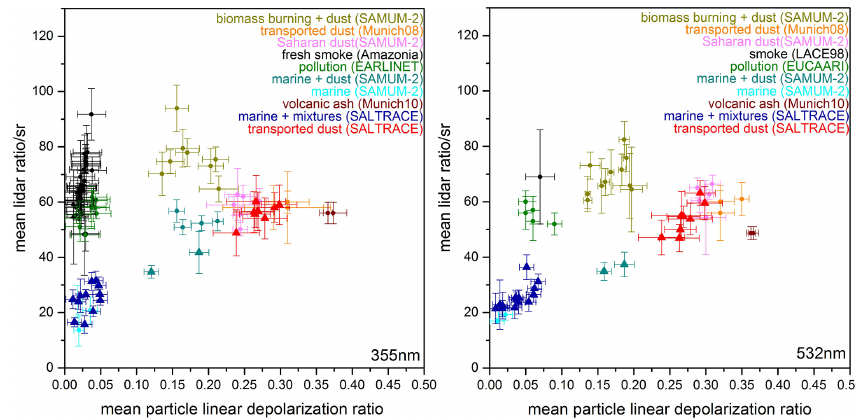
Figure 14. Aerosol classification at 355nm (left) and 532nm (right) based on the lidar ratio and the particle linear depolarization ratio. Mea- surements at 355nm were performed with the ground-based Raman polarization lidars POLIS (Ludwig-Maximilians-Universität München) and with PollyXT of the Leibniz Institute for Tropospheric Research. Measurements were conducted during SAMUM-2 in Cape Verde (Sa- haran dust, marine, marine and dust and biomass burning and dust; Groß et al., 2011b), in the framework of EARLINET in Leipzig, Germany (pollution; Illingworth et al., 2015), and in Munich, Germany (volcanic ash, transported dust; Groß et al., 2012; Wiegner et al., 2011), and in the Amazon Basin (fresh smoke; Baars et al.,